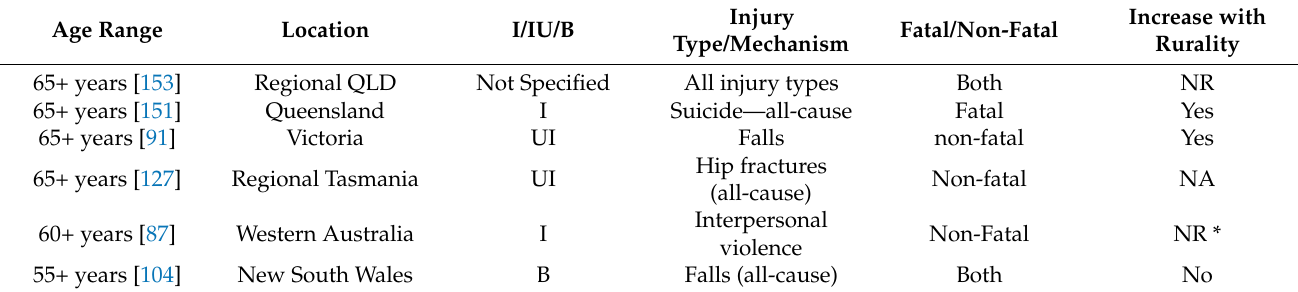
Table 7. Elder Rural Injury